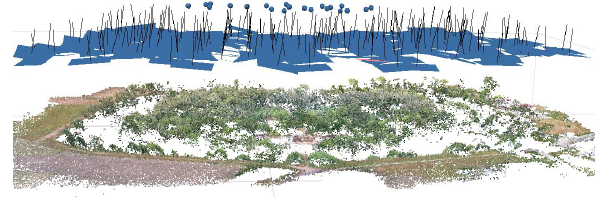
Figure 10. Camera stations and sparse point cloud